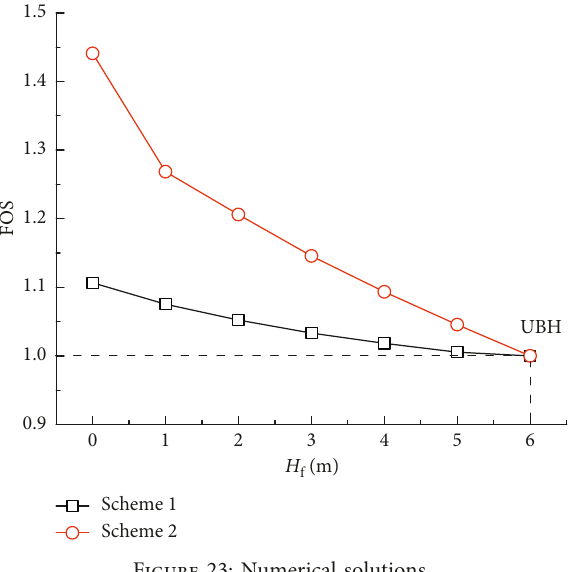
Figure 23: Numerical solutions.